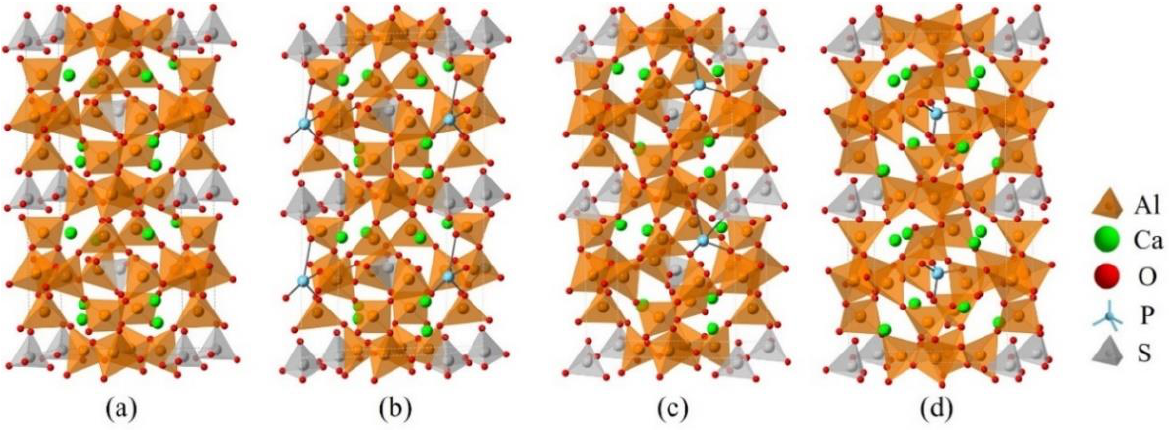
Figure 6. Crystalline structures of orthorhombic ye ’ elimite (ST) and the doped models (1 × 1 × 1), ( a ) pure, ( b ) P2@Al1, ( c ) P2@Al2, ( d ) P2@Ca, and ( e ) P2@S.